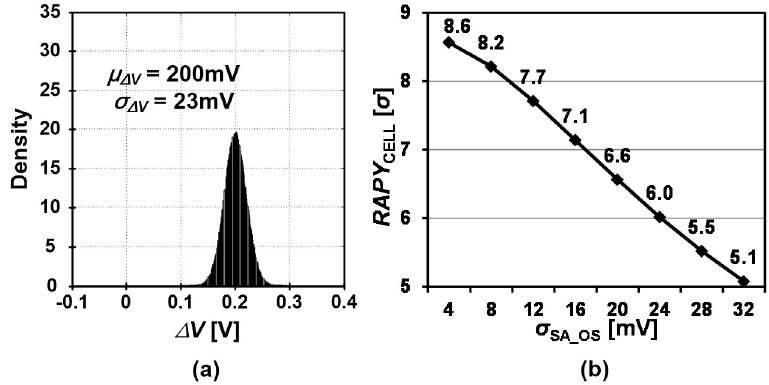
Figure 1. ( a ) Example of Δ V distribution of the offset-canceling dual-stage sensing circuit (OCDS-SC) at μ ∆ V = 200 mV and σ ∆ V = 23 mV. ( b ) RAPY CELL according to σ SA_OS .